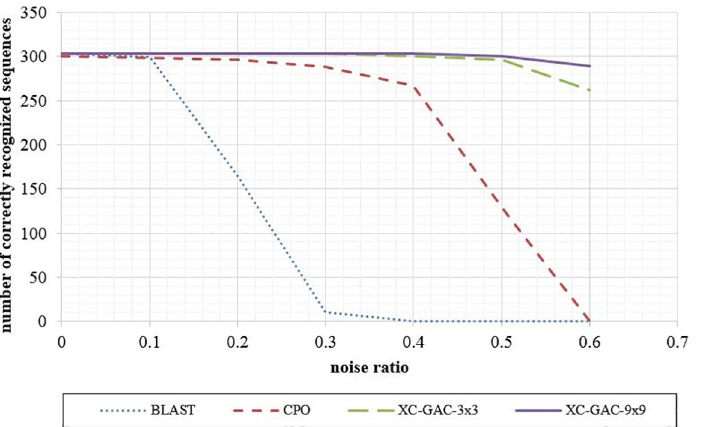
Fig 10. Snetivity and mutation rates for three method; BLAST, cross-correlator based on integer coding set (CPO), and cross-correlator based on GAC coding set (XC-GAC).